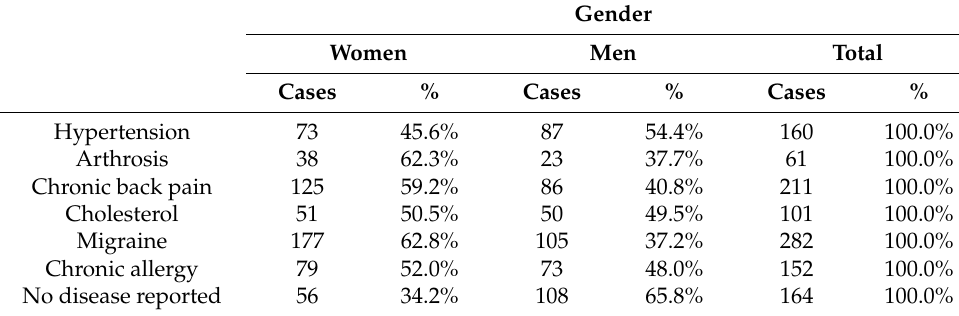
Table 1. Chronic diseases by gender ( N =